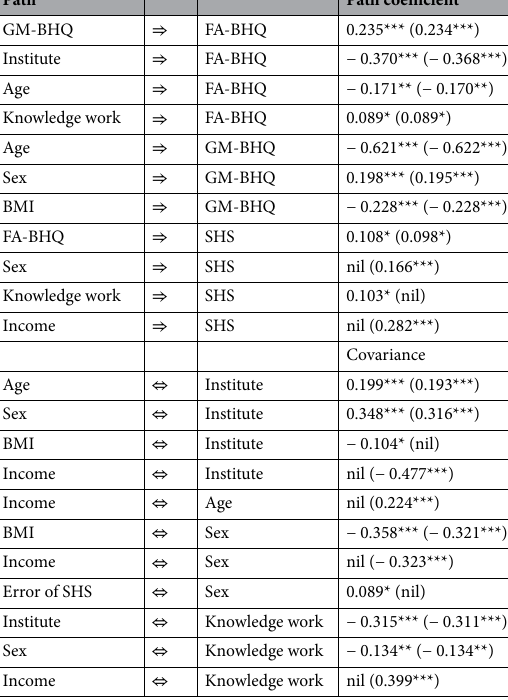
Table 3. Path coefficient. n = 417; *p < 0.05; **p < 0.01; ***p < 0.001. The figures are controlled for sex, BMI, knowledge work, and institute. The numbers in parentheses are the ones when income is added to the